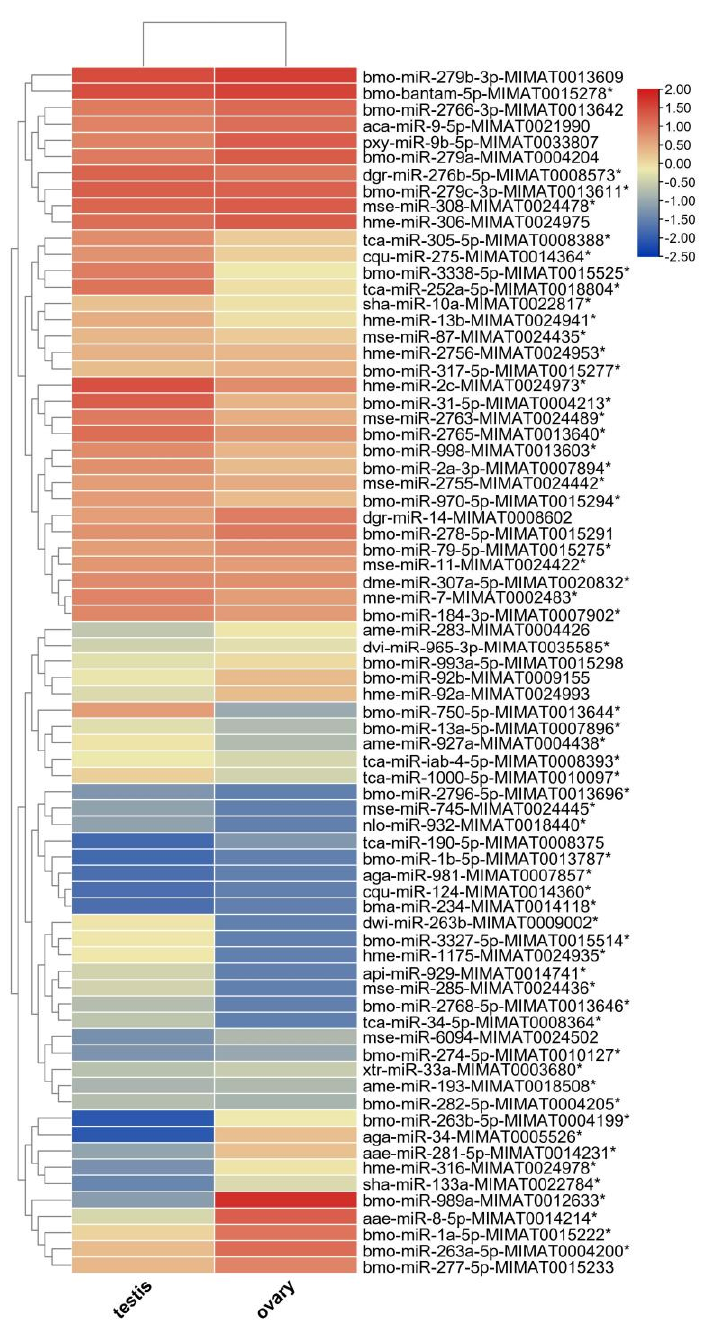
Figure 5. Expression levels of known miRNAs in the testes and ovaries of 0-day-old male adults and 2-day-old female adults of H. armigera . Putatively biased miRNAs (|log 2 FC| ≥ 1) between the testis and ovary are labeled with *.